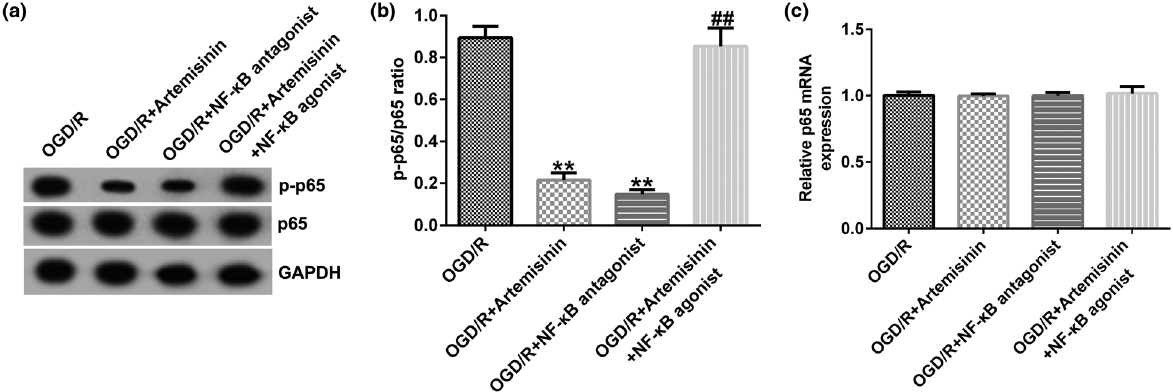
Figure 8: NF - κ B agonist reverses the inhibitory e ff ect of ART on the NF - κ B signaling pathway in OGD/R - exposed SH - SY5Y cells. SH - SY5Y cells were pre - treated with 100 μ M ART, an NF - κ B antagonist, or 100 μ M ART + NF - κ B agonist for 2 h and then exposed to OGD/R. ( a ) Protein expressions of p - p65 and p65 were measured using western blotting. ( b ) p - p65/p65 ratio. ( c ) mRNA expression of p65 was determined via RT - qPCR. ** p < 0.01 vs OGD/R; ## p < 0.05, 0.01 vs OGD/R